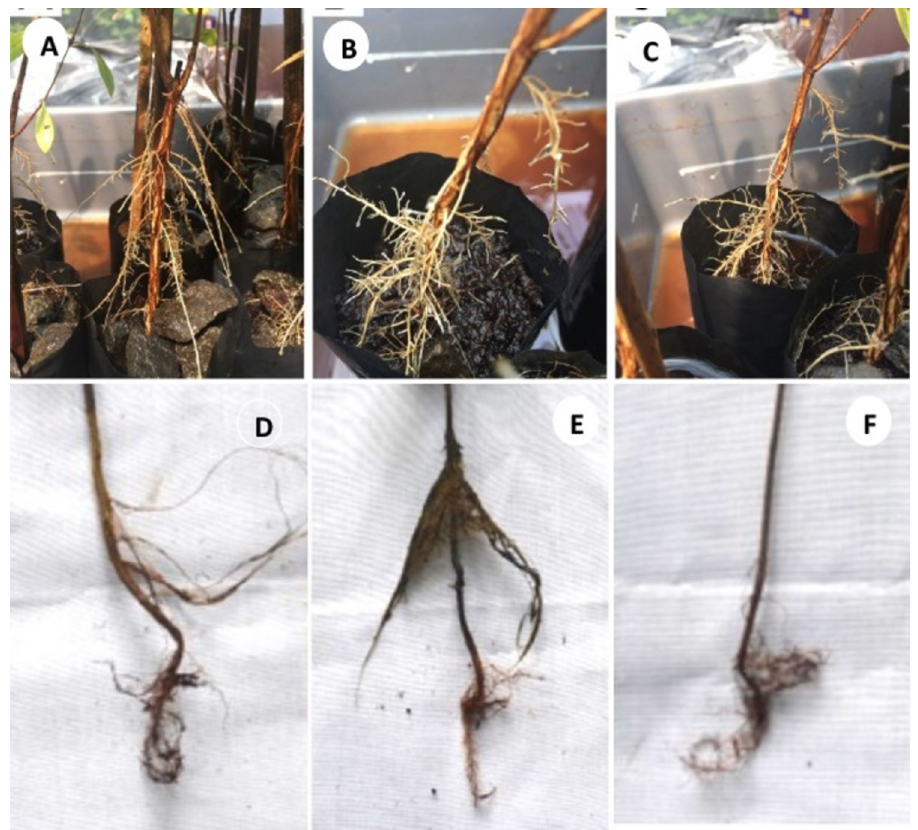
Fig 5. Adventitious root formation of C . arborescens (A-C) and S . balangeran (D-F) at the ⅓ stem height flooding. (A) & (D) 0% shading; (B) & (E) 30% shading; (C) & (F) 70% shading.